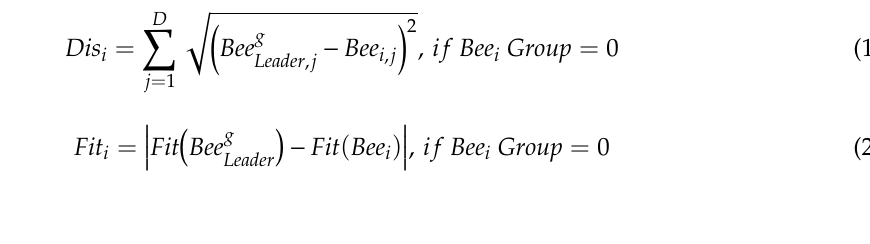
Figure 10. Similar bees are put in the same group. If there are bees not yet grouped, the bee with the best fitness is selected from the ungrouped bees in step 3 as the leader of a new group. The grouping actions are repeated until all ungrouped bees are grouped. As shown in Figure 11: Figure 11. Group the ungrouped bees. Step 4 (bee movement): When all the bees are grouped, the bee move search is implemented to find the best food source. In order to increase the efficiency of the algorithm, the traditional move mode of employed bees is improved in this study; hence, the information of optimal solution is added to the global search of employed bees. On the one hand, the employed bees advance towards the best food source. On the other hand, the random search mechanism of conventional ABC is maintained, so as to avoid too fast algorithm convergence which can easily to fall into the local solution. The improved employed bees search is expressed as follows: (cid:1848) (cid:3036),(cid:3037) = (cid:1850) (cid:3036),(cid:3037) + ∅1 (cid:3036),(cid:3037) (cid:3435)(cid:1850) (cid:3029)(cid:3032)(cid:3046)(cid:3047),(cid:3037) − (cid:1850) (cid:3036),(cid:3037) (cid:3439) + ∅2 (cid:3036),(cid:3037) ((cid:1850) (cid:3038),(cid:3037) − (cid:1850) (cid:3036),(cid:3037) )